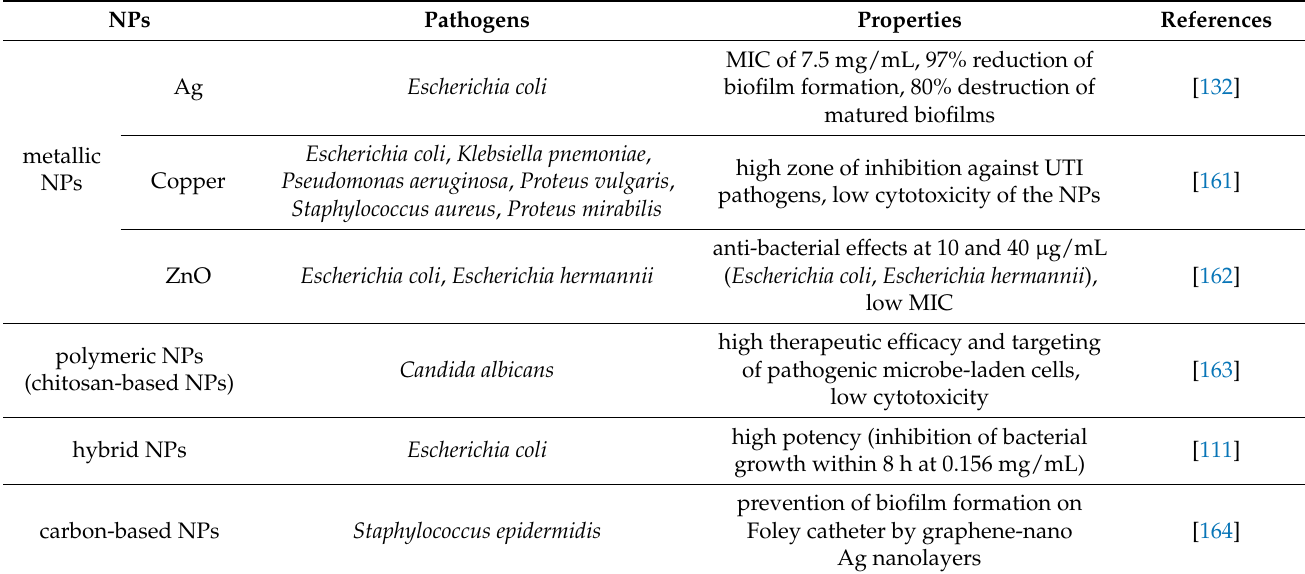
Table 2. Most commonly used NP-based delivery approaches for therapy against